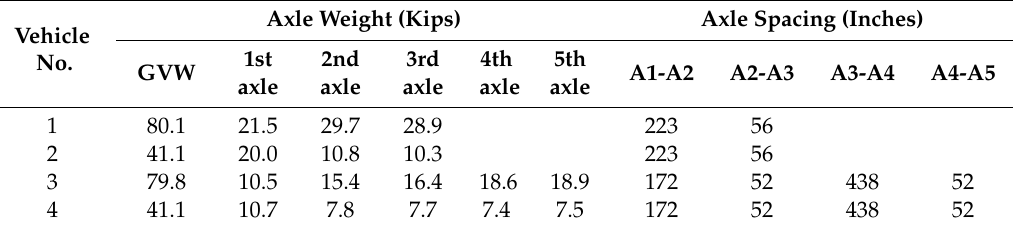
Table 3. Calibration vehicle weights and spacings.